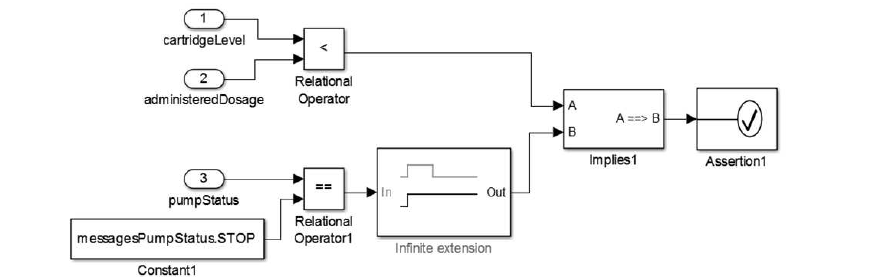
Figure 27. Safety Property 2.